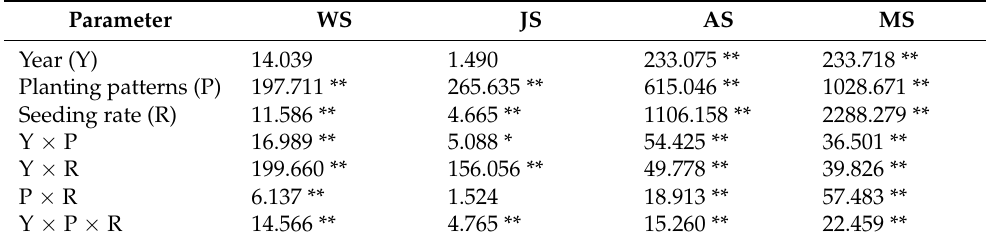
Table 3. Significance analysis (F value) of interactive effects of year, planting patterns, and seeding rate on the dry matter accumulation at four growth stages over two years.